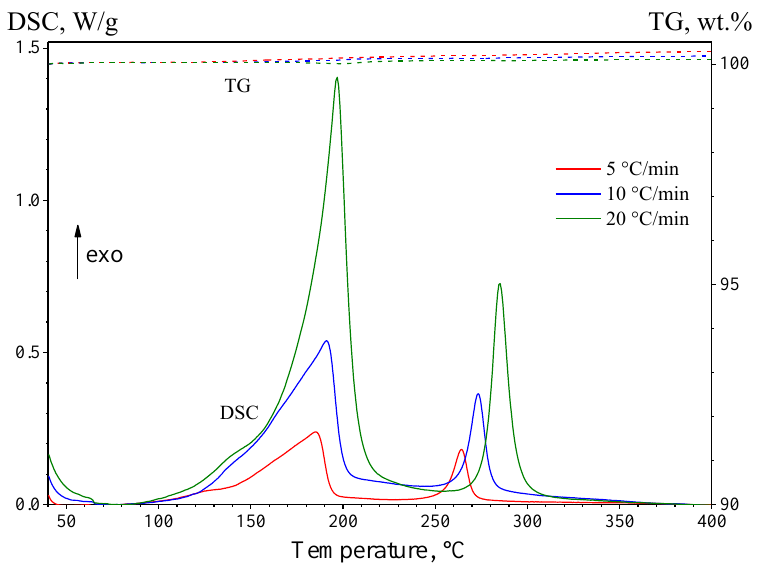
Figure 6. DSC-TG curves of the (Cu/a-Si) 30 multilayer sample at different heating rates: 5, 10, and 20 °C/min.